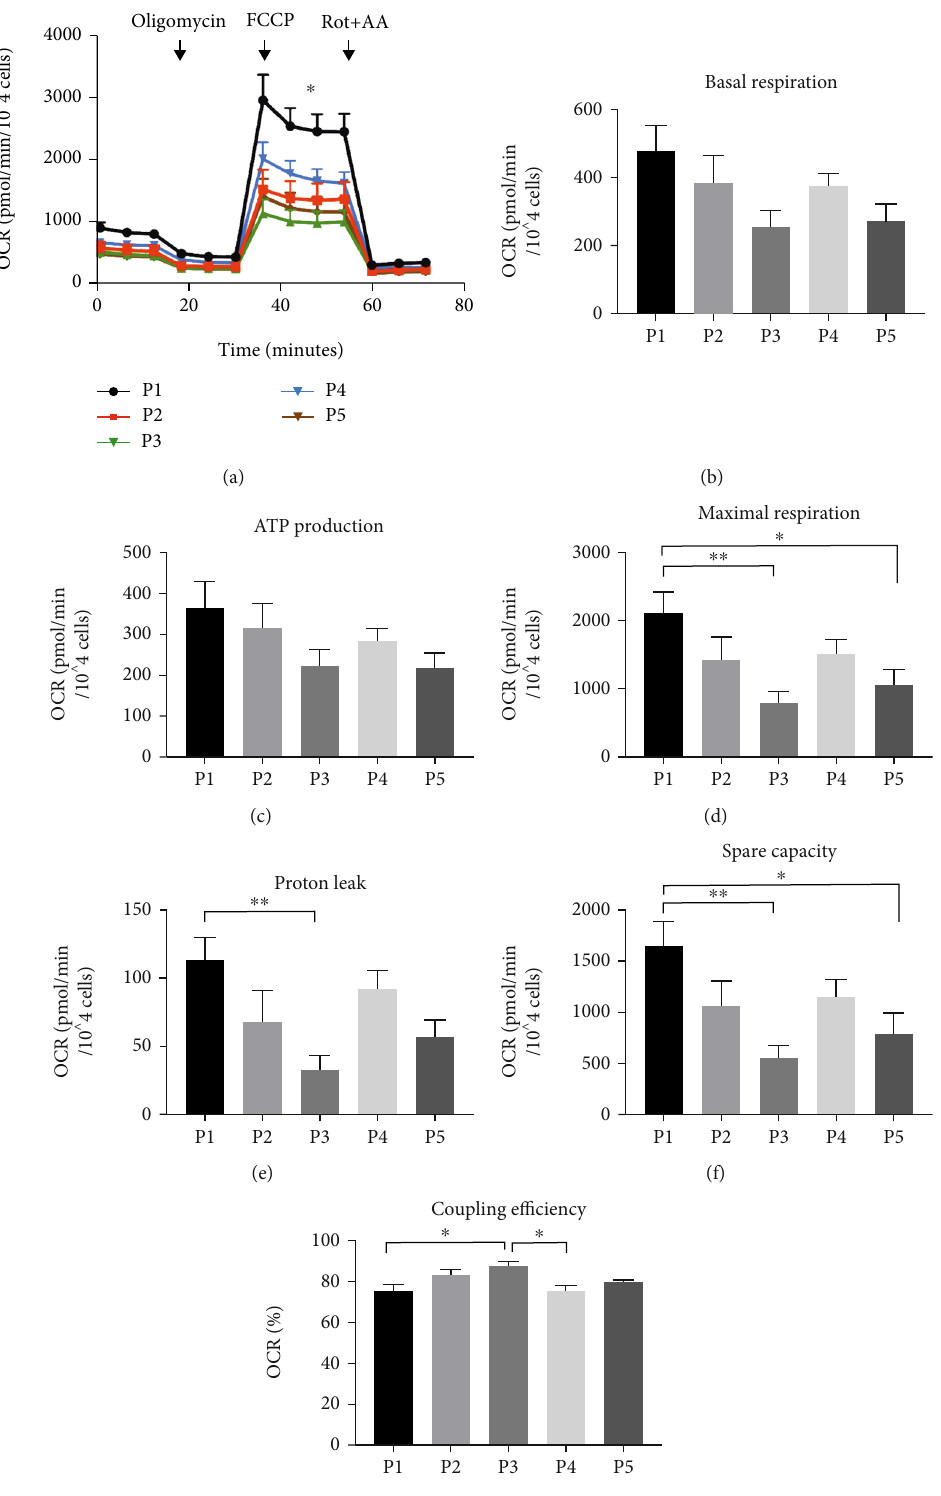
Figure 4: E ff ect of di ff erentiation protocols on mitochondrial respiration. (a) Oxygen consumption rate (OCR) measured in adipocytes di ff erentiated for 21 days with fi ve di ff erentiation media. Calculated average values of (b) basal respiration, (c) ATP production, (d) maximal respiration, (e) proton leak, (f) spare respiratory capacity, and (g) coupling e ffi ciency (%) ( ð ATPproduction/basalrespiration Þ ∗ 100 ). Statistical analysis was performed using one-way ANOVA followed by Tukey ’ s post hoc analysis ( n = 6 ): ∗ p < 0 : 05 , ∗∗ p < 0 : 01 . Error bars are shown as